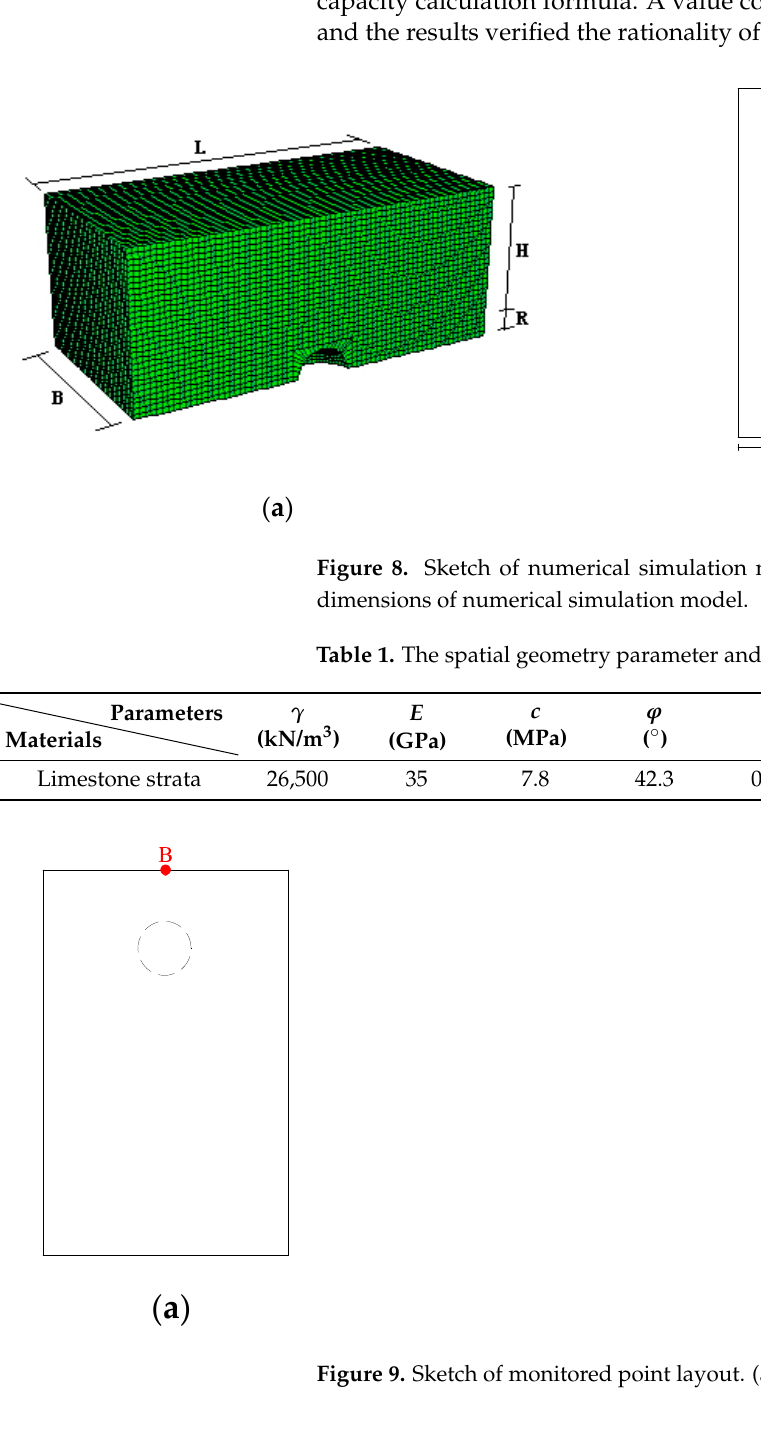
Table 2. Applied load and corresponding subside of the critical point.